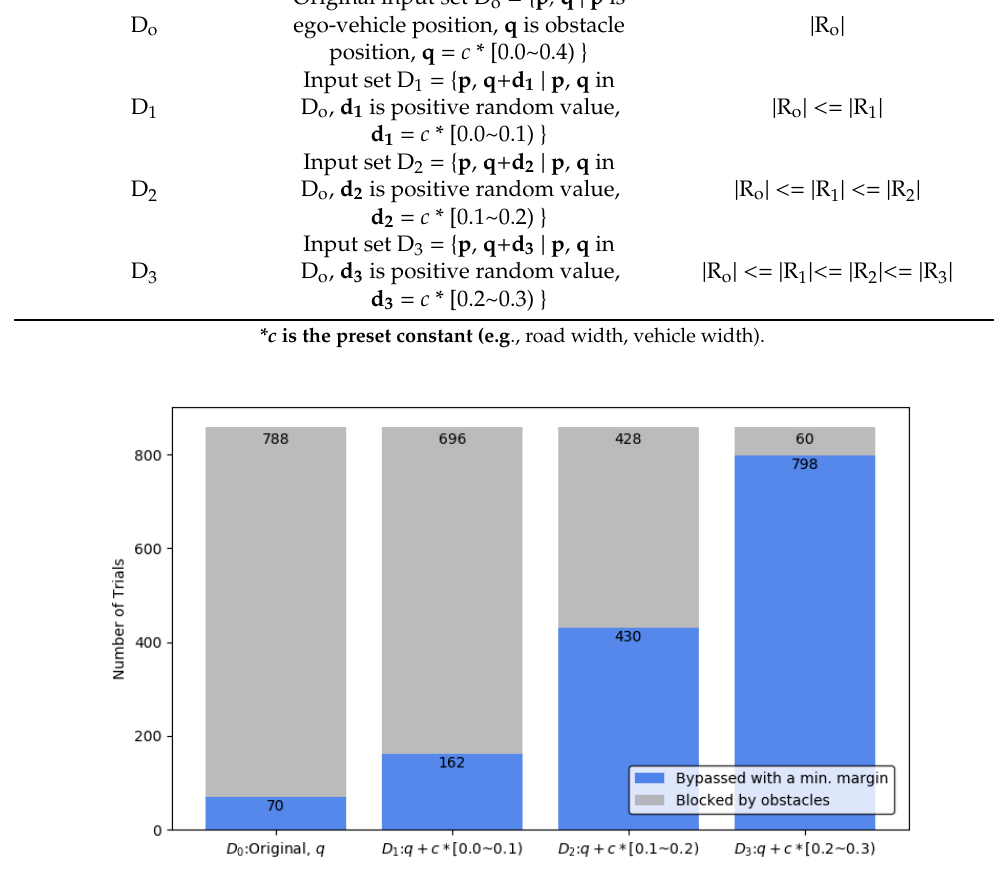
Figure 16. Avoiding obstacles test results.